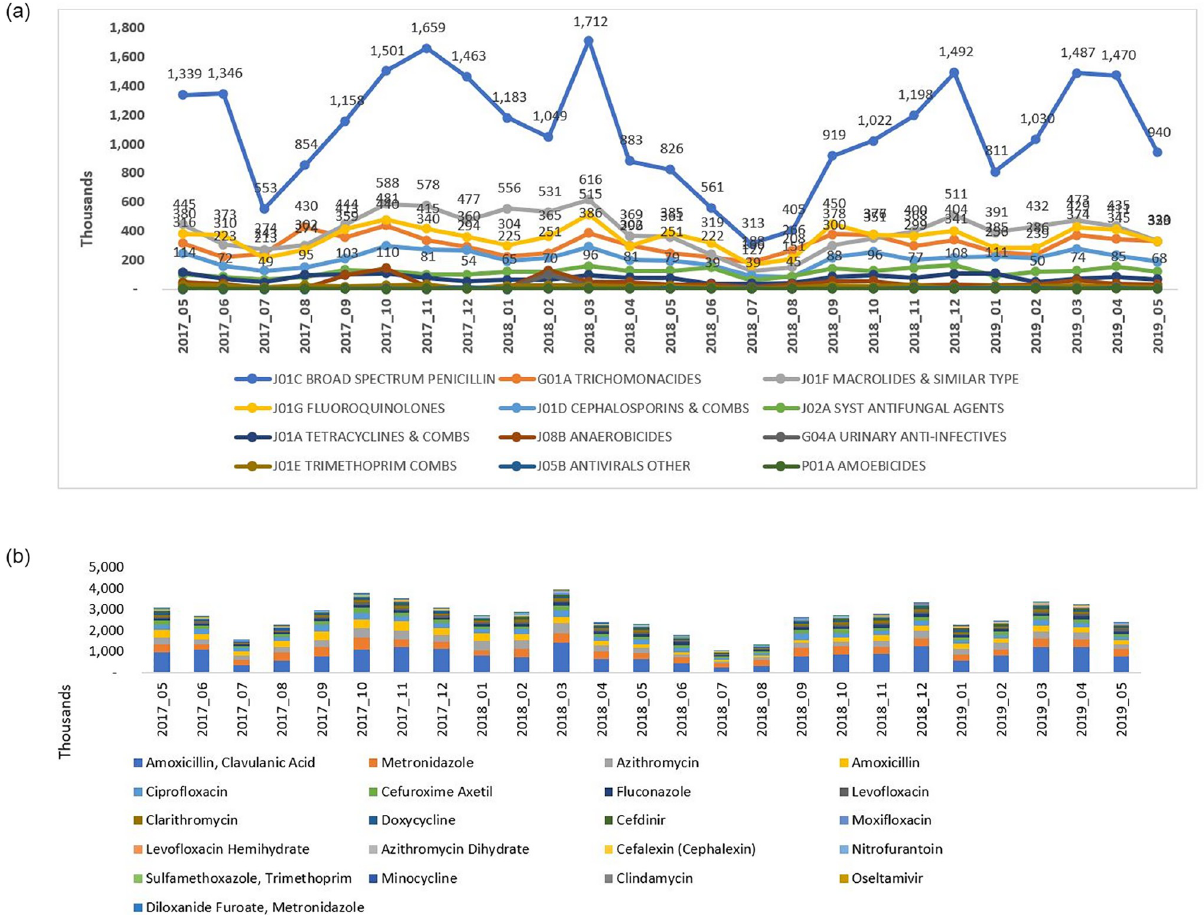
Fig 3. Antimicrobial sales volume in the years pre-and post-policy enforcement in Saudi Arabia. A] Antimicrobial sales by chemical class (ATC3 classification), B] Antimicrobial sale by